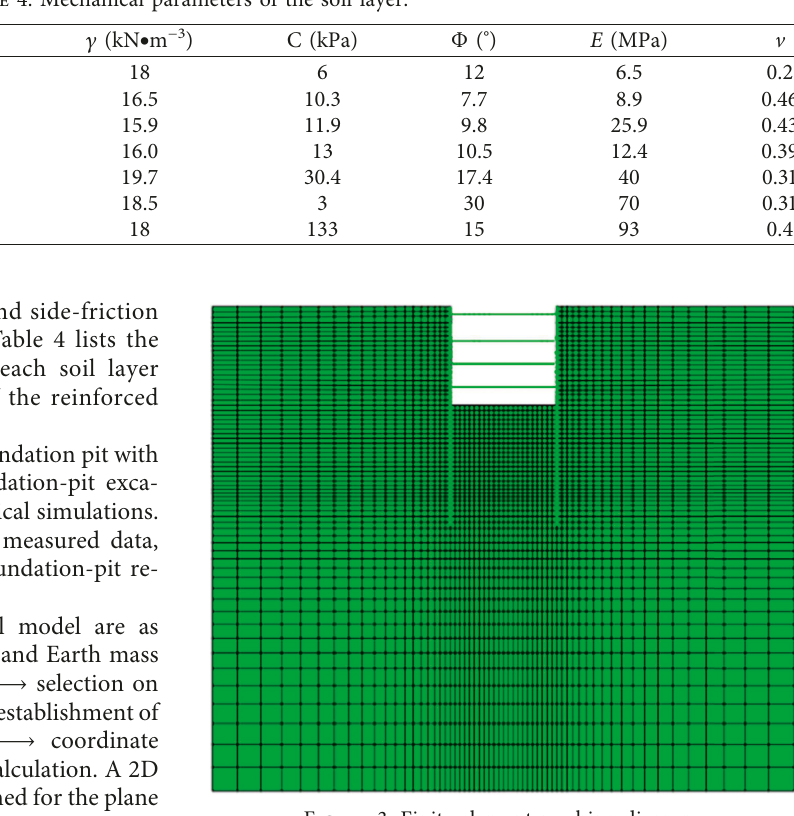
Table 4: Mechanical parameters of the soil layer.